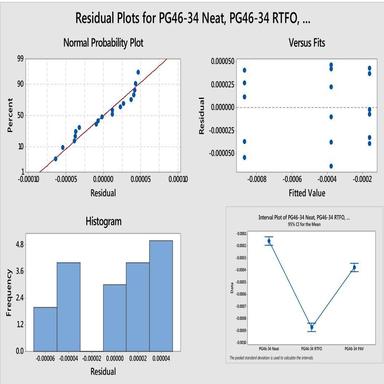
MINITAB plots for different aging levels of PG46-34 binder.